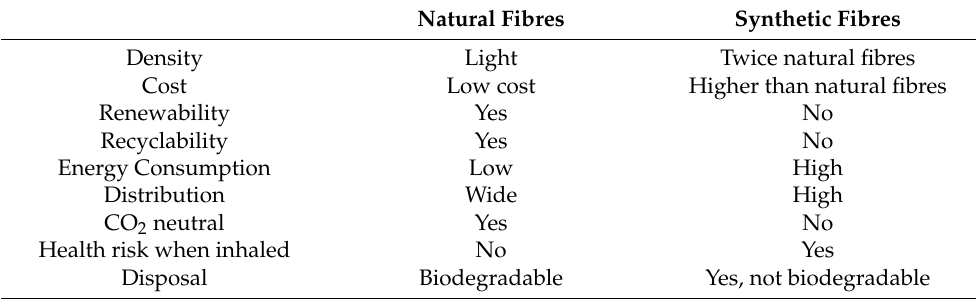
Table 5. Advantages of natural fibres compared to synthetic fibre